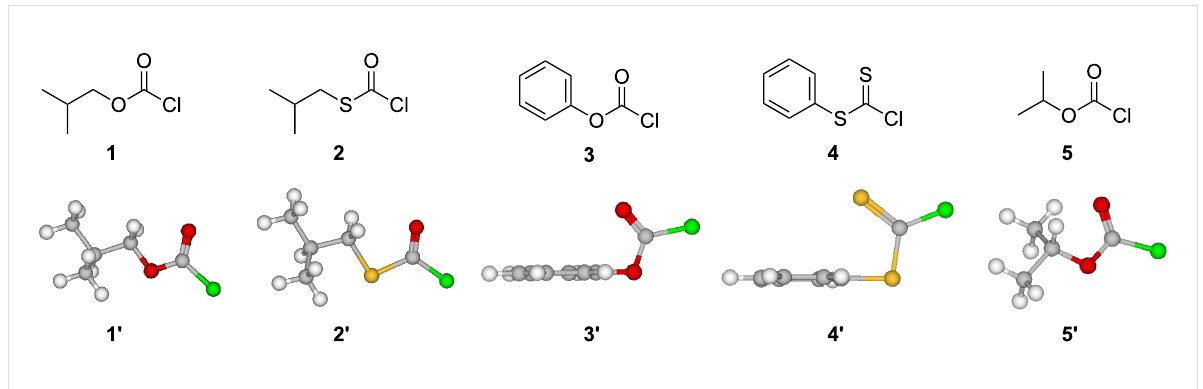
Figure 1: Molecular structures of syn -isobutyl chloroformate ( 1 ), syn -isobutyl chlorothioformate ( 2 ), phenyl chloroformate ( 3 ), phenyl chlorodithiofor- mate ( 4 ), and isopropyl chloroformate ( 5 ). The 3-D images for syn -isobutyl chloroformate ( 1' ), syn -isobutyl chlorothioformate ( 2' ), phenyl chlorofor- mate ( 3' ), phenyl chlorodithioformate ( 4' ), and isopropyl chloroformate ( 5' ) are also